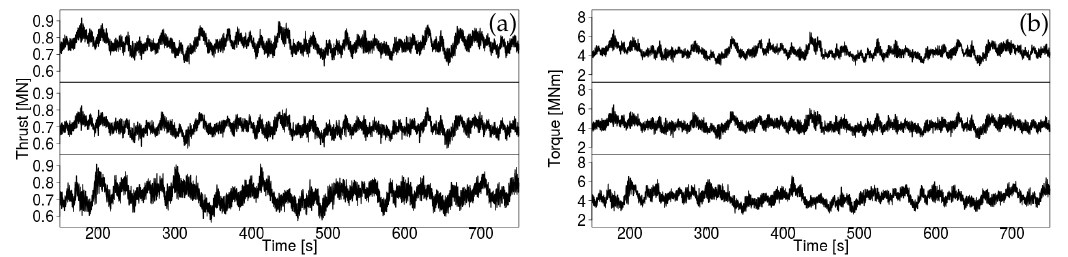
Figure 12. Time series for ( a ) thrust and ( b ) torque for Blade Resolved (BR), Actuator Line (AL) and Blade Element Momentum (BEM) methods (from top to bottom).